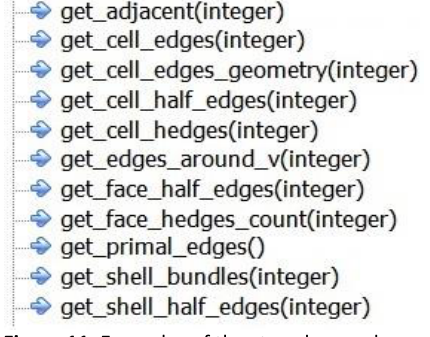
Figure 11 . Examples of the stored procedures.